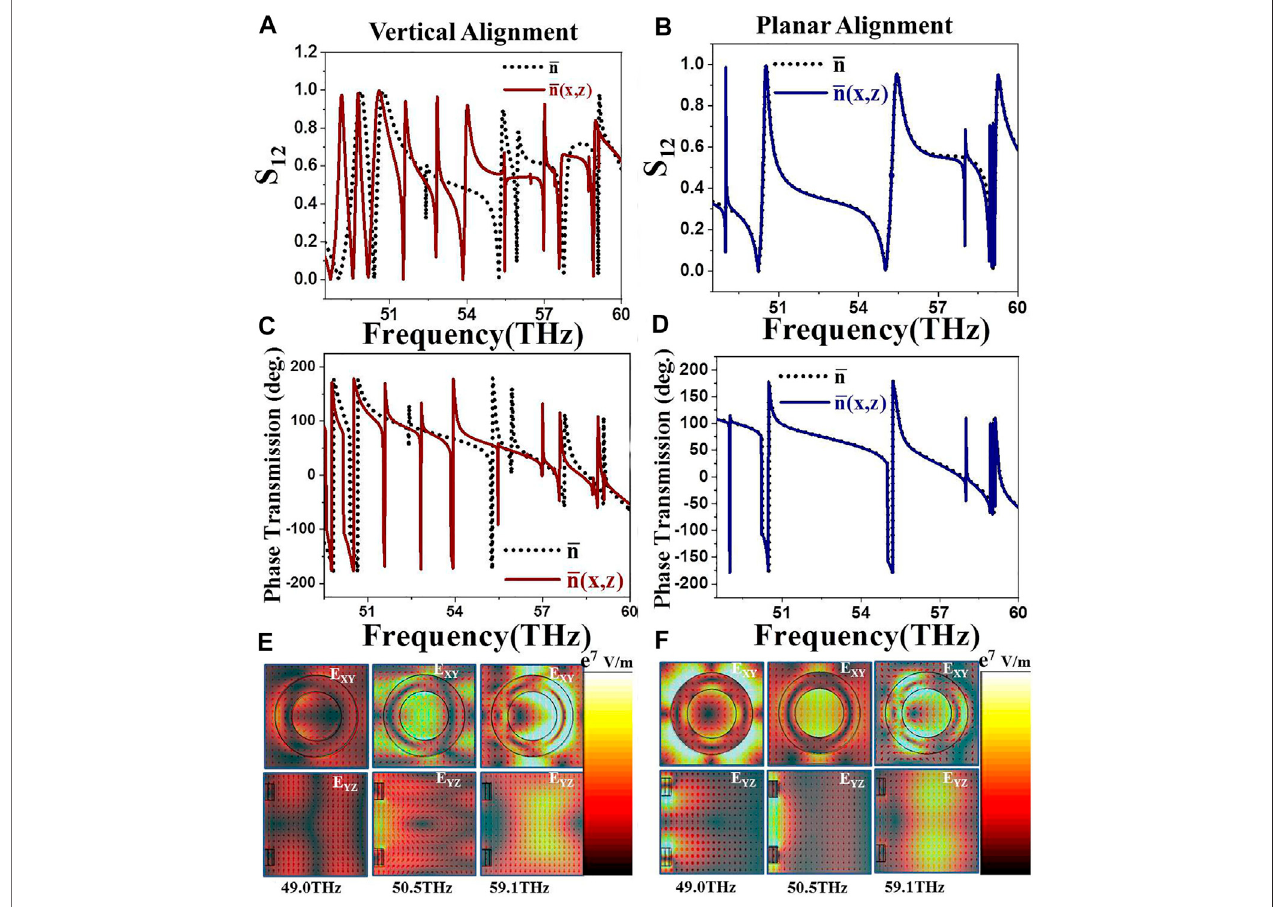
FIGURE 4 | Electromagnetic response of DFLC with cylindrical ring microstructures: (A,B) . S 12 parameters for vertical (ON state, f L ) and planar aligned con fi guration(OFFstate, f H )ofDFLCcell,respectively. (C,D) .Phaseoftransmittedlightat f L and f H respectively. (E,F) .Near- fi eldpro fi lesofelectric fi eldcomponentsinXY plane (top) and scattered electric fi eld pro fi les in YZ plane (bottom) at f L and f H